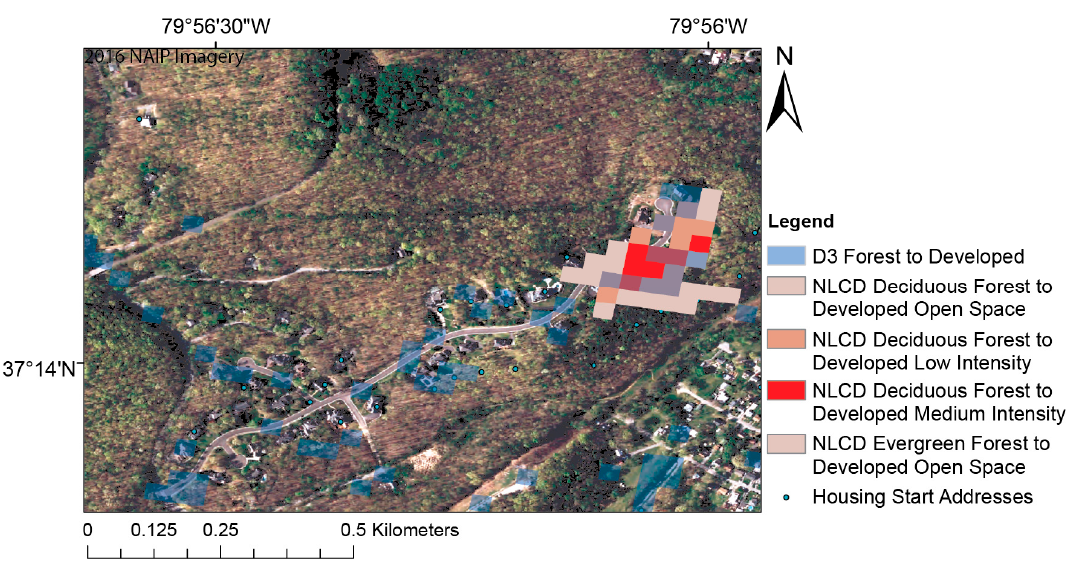
Figure 8. An example of where NLCD detects change once the five-pixel threshold is met compared to the D 3 - based CART model, which is not constrained by that limitation.